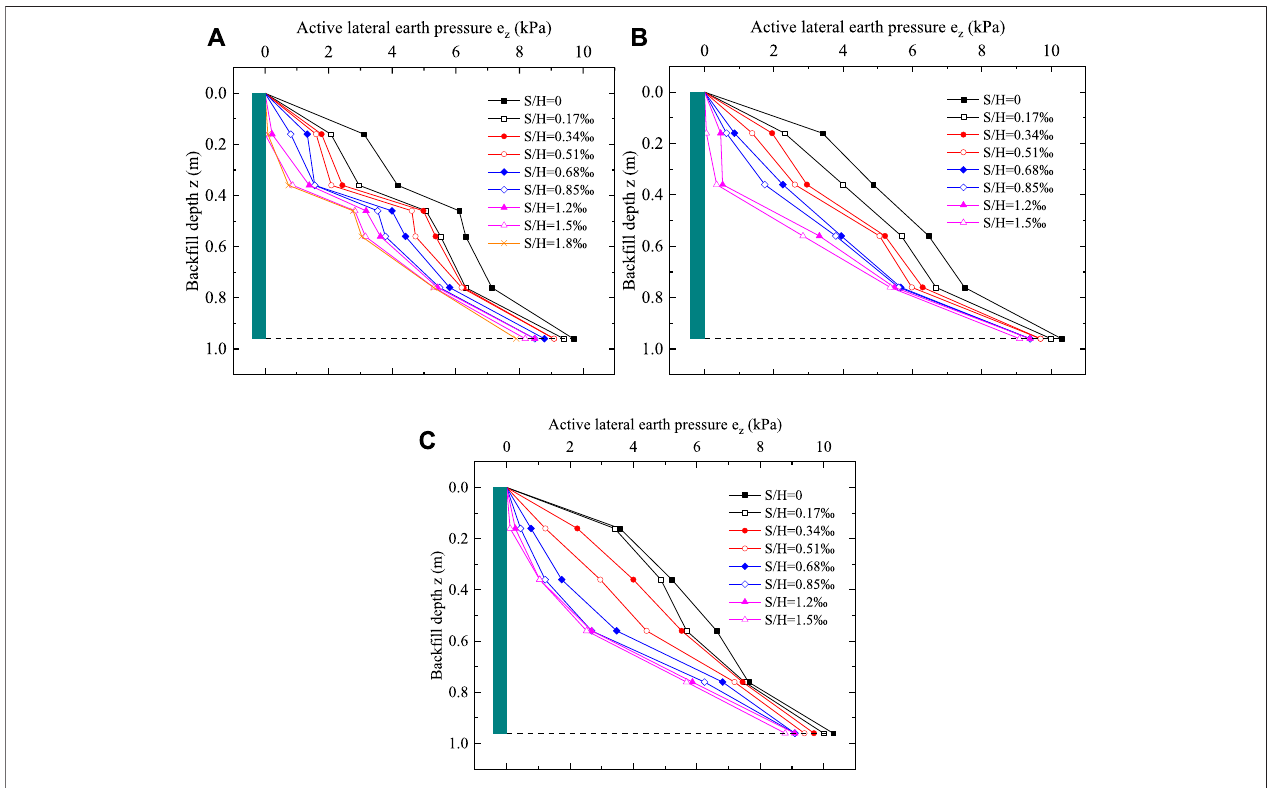
FIGURE 8 | Distribution of active lateral earth pressure with rotational displacement around the wall bottom at different slope angles. (A) β = 40 ° . (B) β = 50 ° . (C) β = 60 ° .